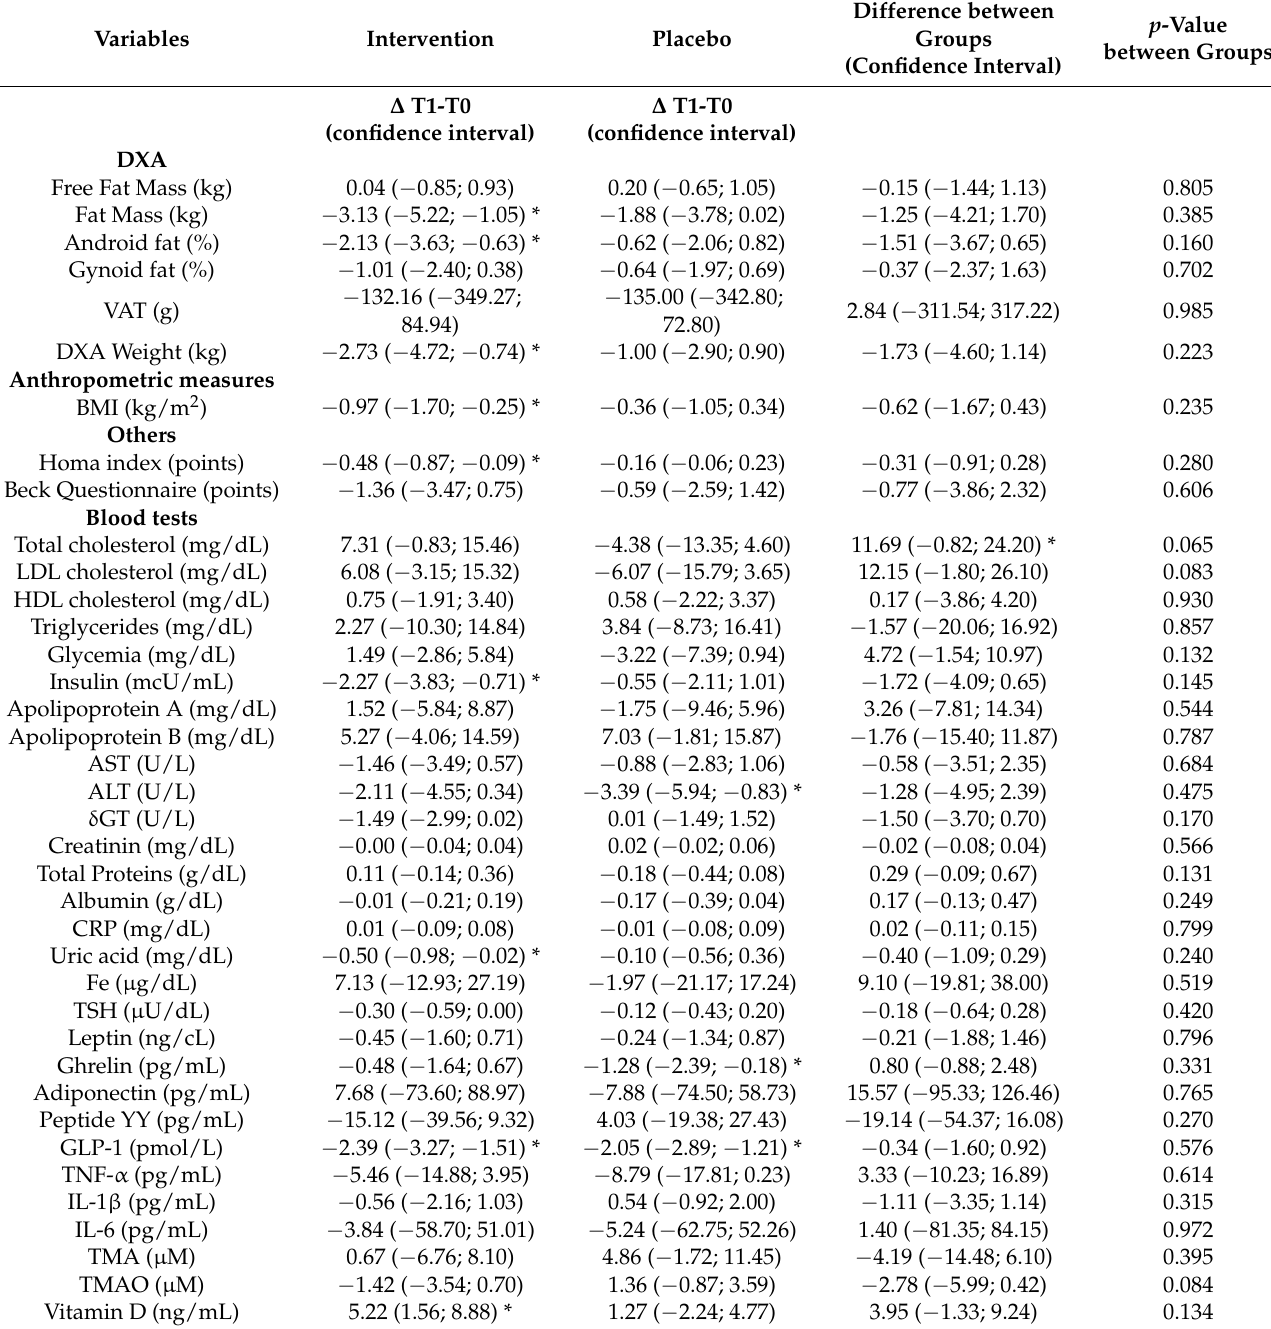
Table 2. Treatment effect from baseline analyzed using linear mixed models and treatment effect between